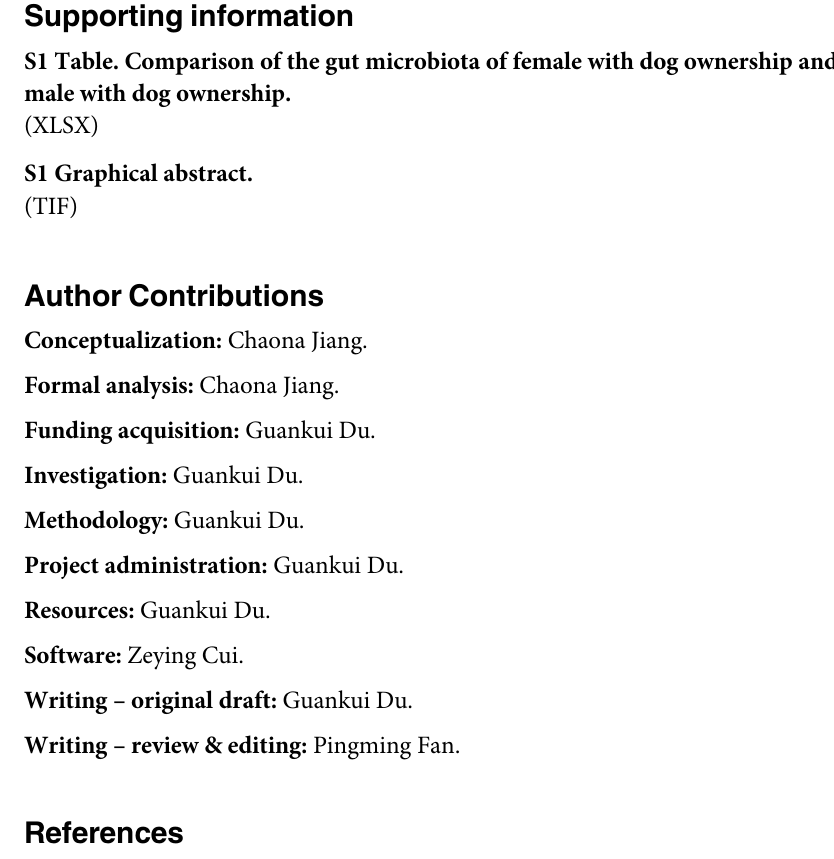
S1 Table. Comparison of the gut microbiota of female with dog ownership and that of male with dog